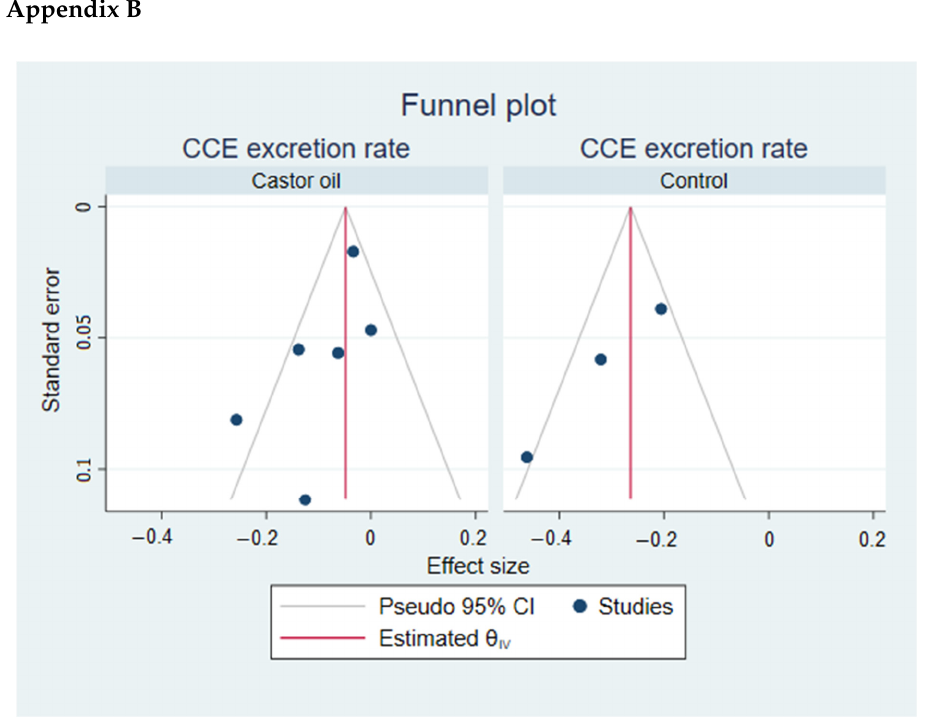
Figure A1. Funnel plots from Egger’s tests visualizing the symmetry of the effect sizes within each sub-analysis of excretion rates from meta-analysis on colon capsule endoscopy using castor oil in the bowel preparation regimen.